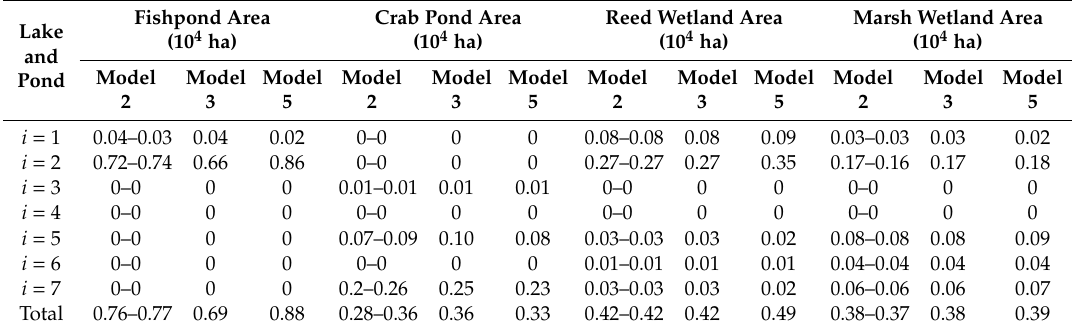
Table 4. Comparison of the restored functional area of region 1, optimized by di ff erent models.